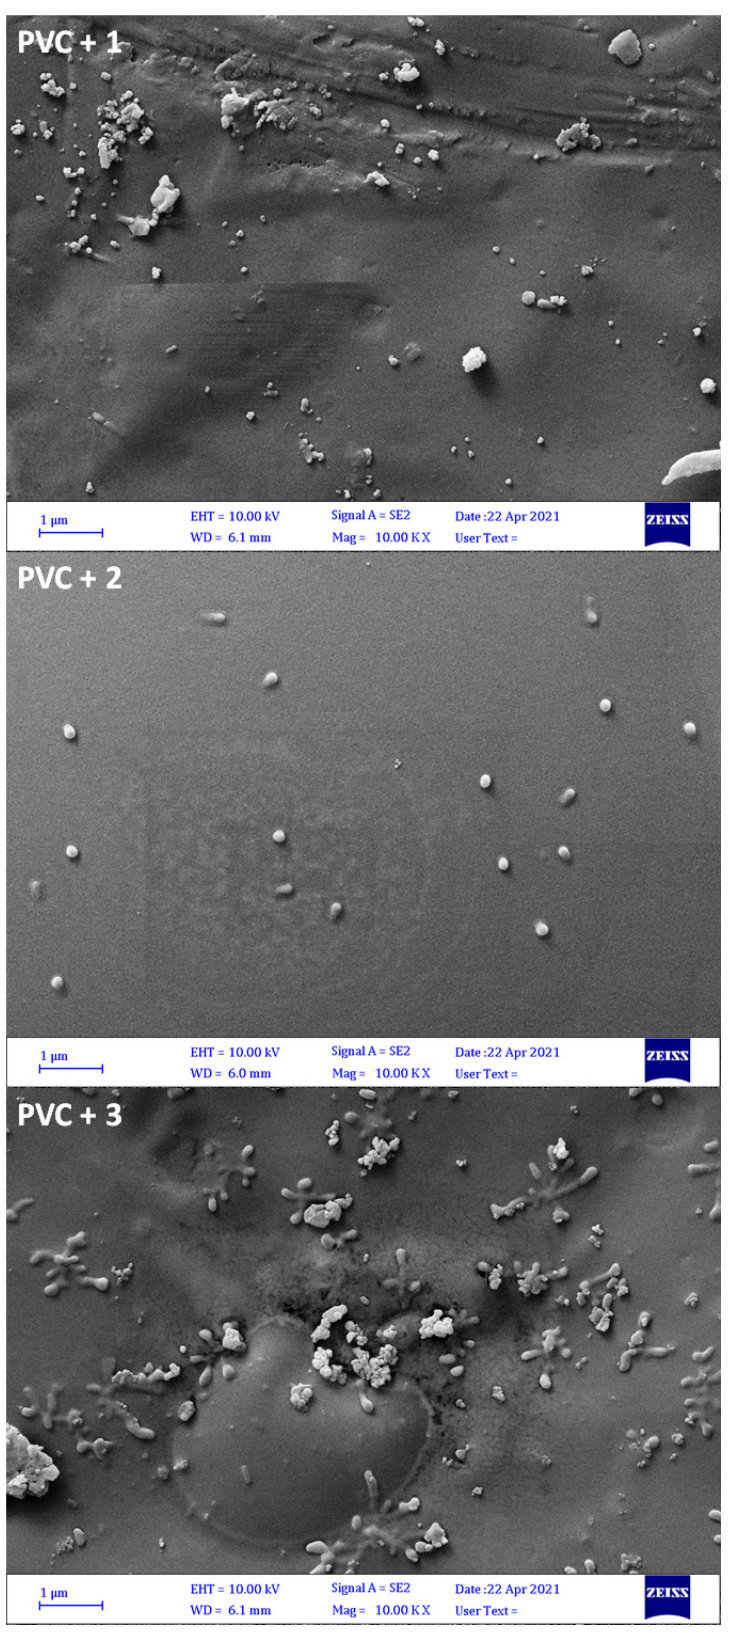
Figure 8. FESEM images of PVC films after irradiation.